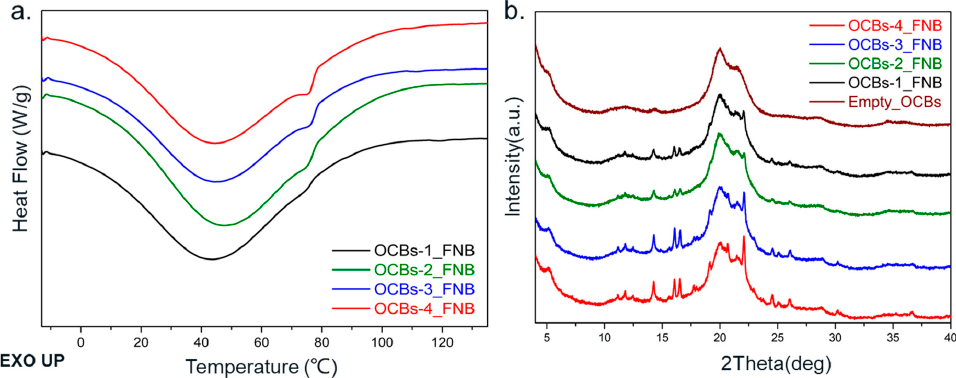
Figure 6. ( a ) DSC thermograms and ( b ) XRPD diffractograms of FNB-loaded OCBs-1 to 4. The baseline curvature in DSC thermograms originates from the evaporation of physically adsorbed